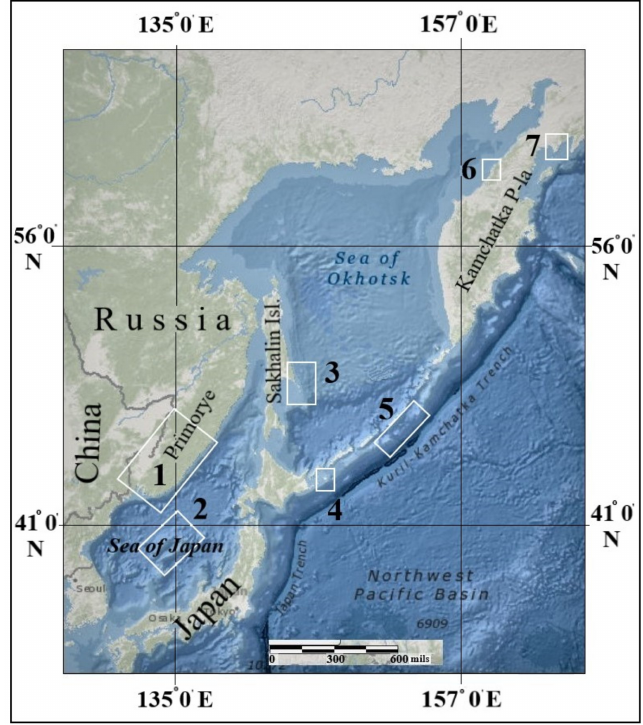
Figure 1. Simplified map of the studied area. 1—Primorye Region, 2—Yamato Upland, 3—Terpeniya